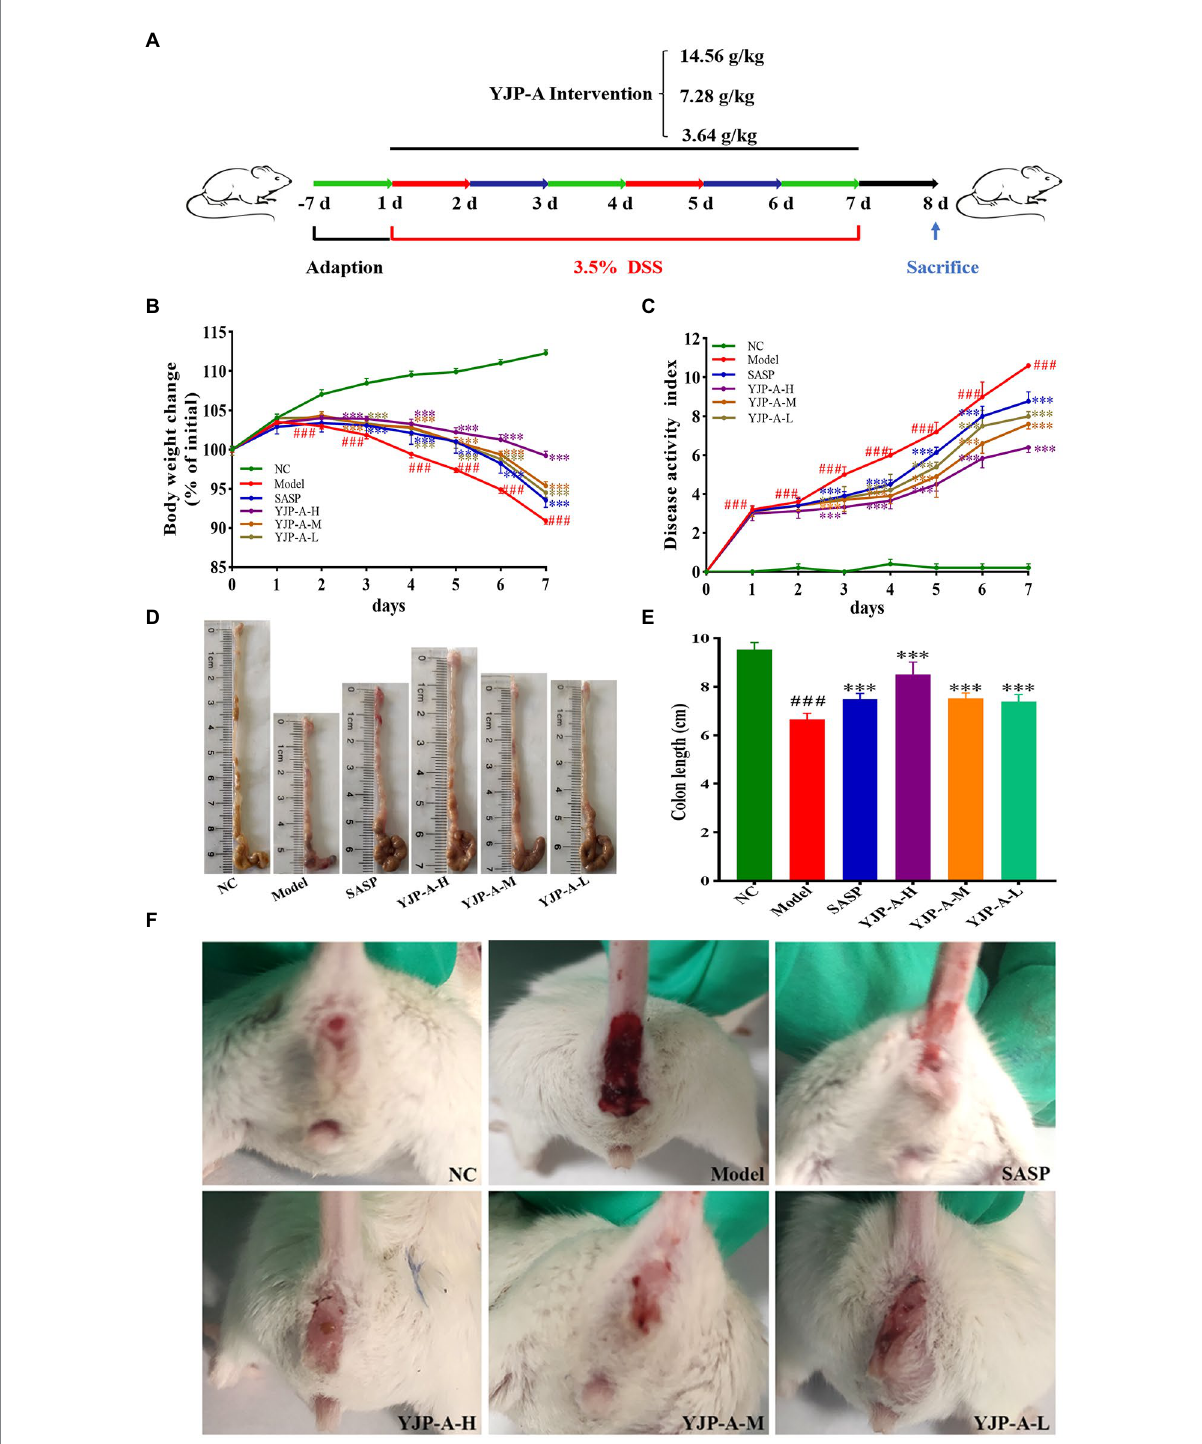
FIGURE 1 YJP-A ameliorates DSS-induced mice UC. (A) Experiments design. Body weight change (B) and disease activity index (C) of the mice during experiment period. YJP-A alleviates DSS-induced colon length reduction (D,E) . Symptoms of hematochezia and diarrhea in mice of each group (F) . Data are expressed as the mean ± SEM, n = 8 per group. ### p < 0.001 vs. NC group; *** p < 0.001 vs. model